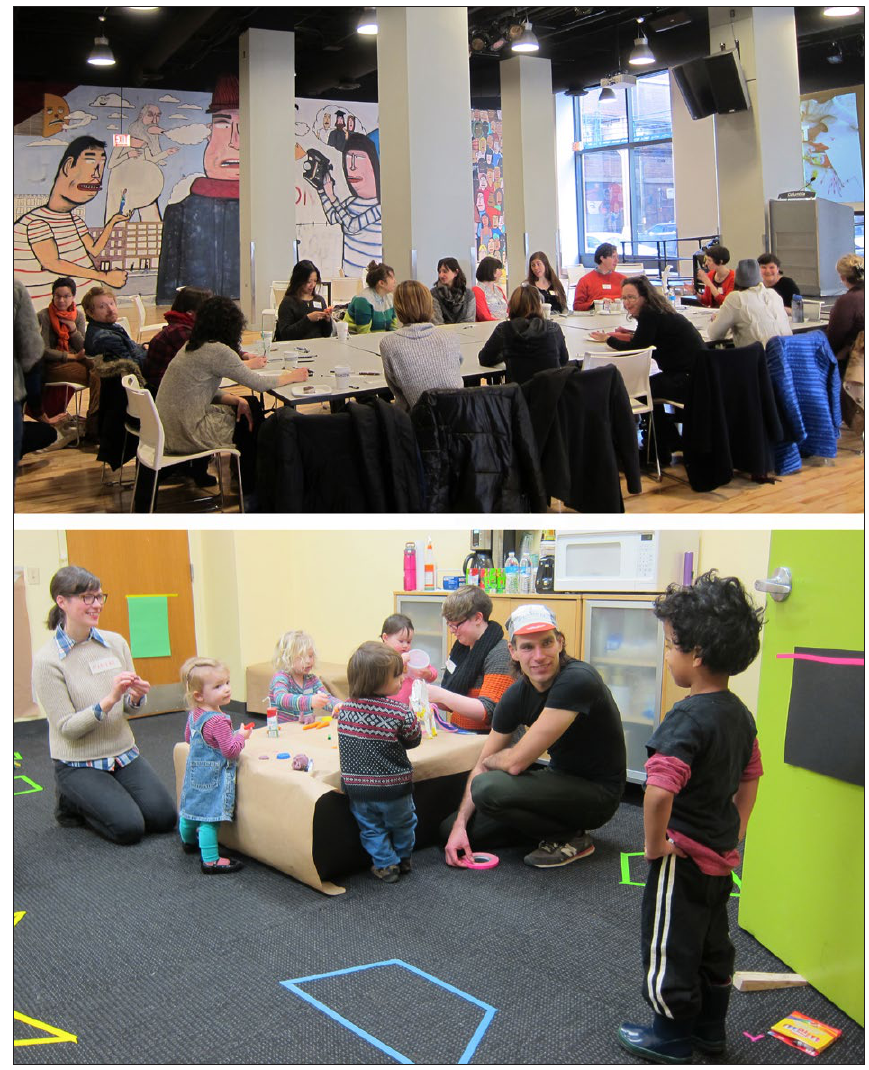
Figure 2: “Making it What We Need,” a generative workshop focusing on the needs of artist-parents, with free, on-site childcare. photos: Andrew